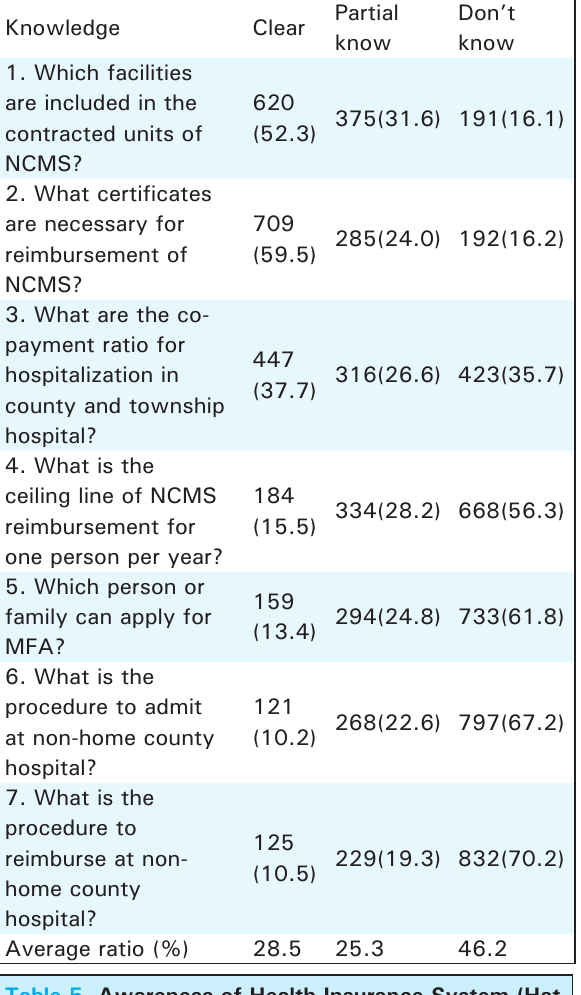
Table 4. Awareness of NCMS (Yulong, LiJiang, China).